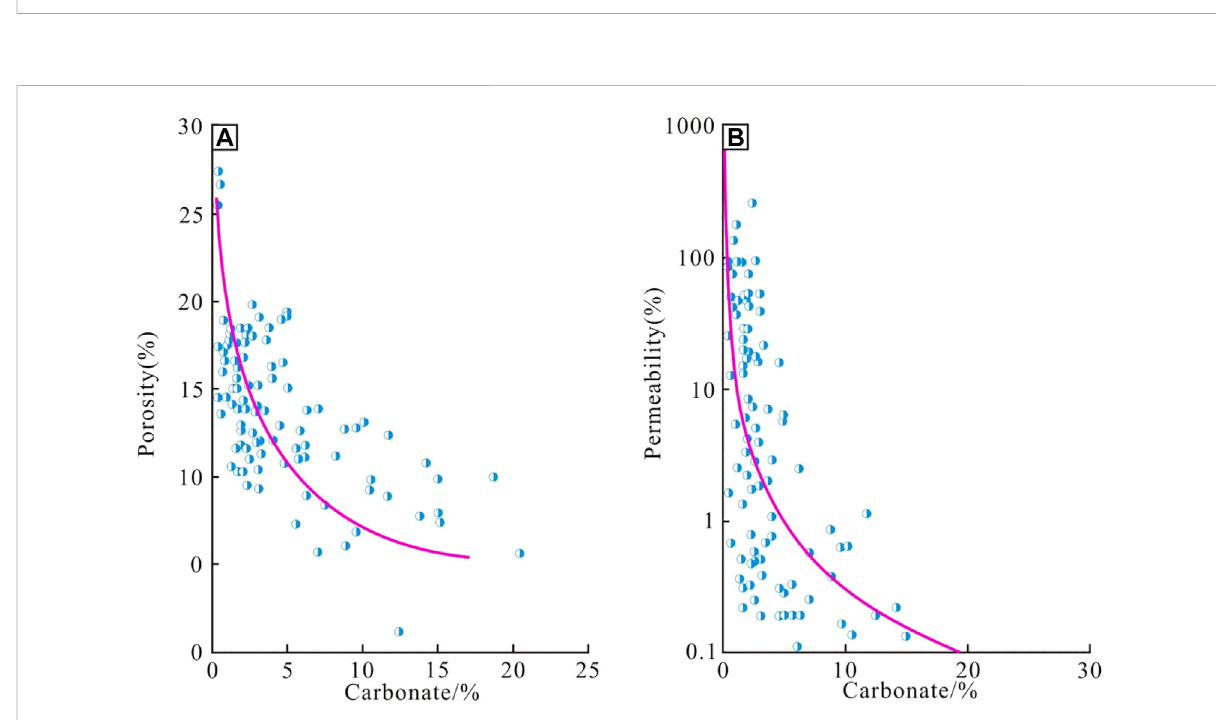
FIGURE 10 Relationship between carbonate content and physical properties of reservoir sand bodies in estuary bars and underwater distributary channels. (A) . Relationship between porosity and carbonate content; (B) . Relationship between permeability and carbonate content.